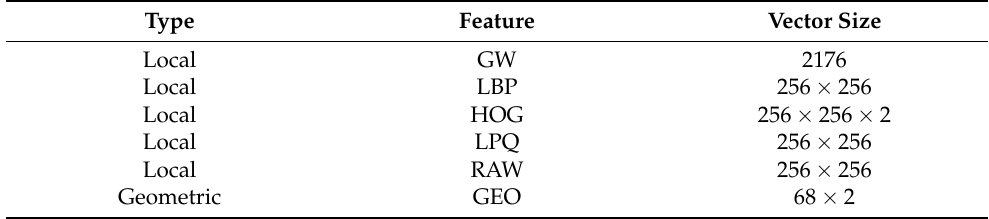
Table 2. Feature summary. For each feature, we provide its type and